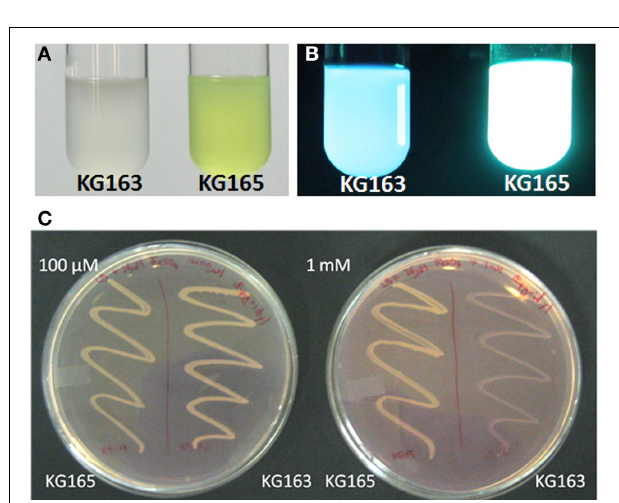
FIGURE 2 | KG163 (PVD synthesis mutant of P. putida GB-1) and KG165 (WT equivalent) grown in succinate medium and visualized under normal light (A) and UV (B). KG163 and 165 grown on LB supplemented with 36 μ M FeSO 4 and different amounts of 2 (cid:4) -2 (cid:4) dipyridyl (C) . Plate on the left has 100 μ M and the right has 1mM dipyridyl while the left side of each plate is the WT equivalent and on the right side of each plate is the NRPS